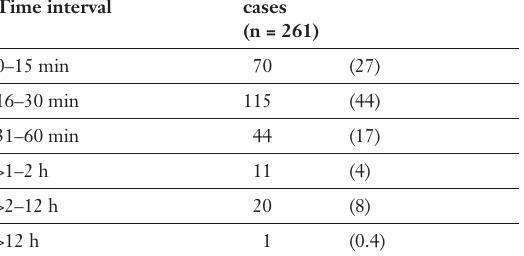
Time interval be- tween oral ingestion of lethal dose of pen- tobarbital (10, 12, or 15 g) and death. Figures are numbers (column percentage) of